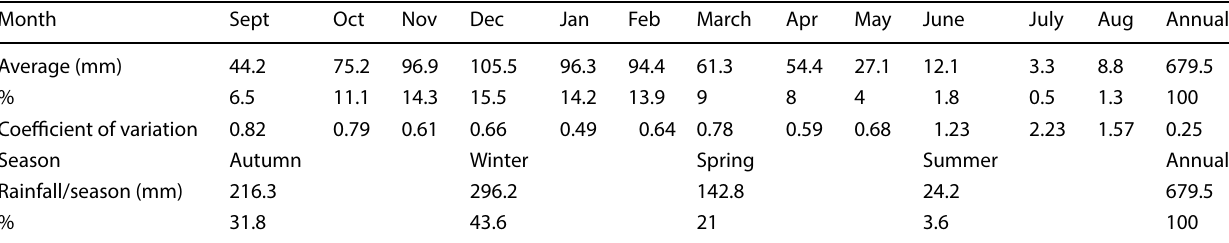
Fig. 3 Time series of annual rainfall (1968–2009) over Ghèzala Dam